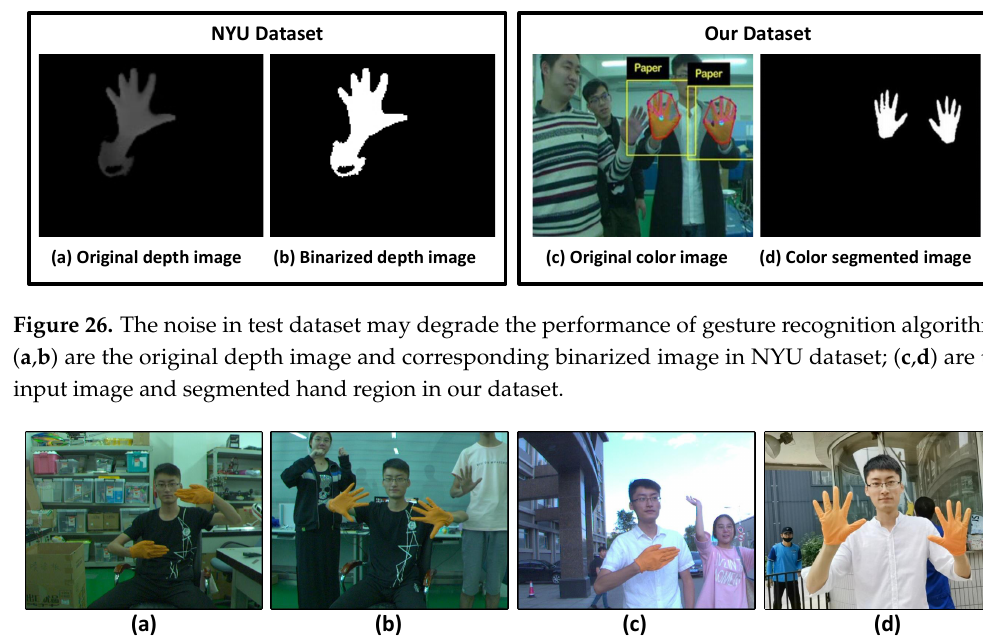
Figure 27. Complex background conditions of our dataset. ( a – d ) Including indoor, outdoor, multiple persons and cluttered